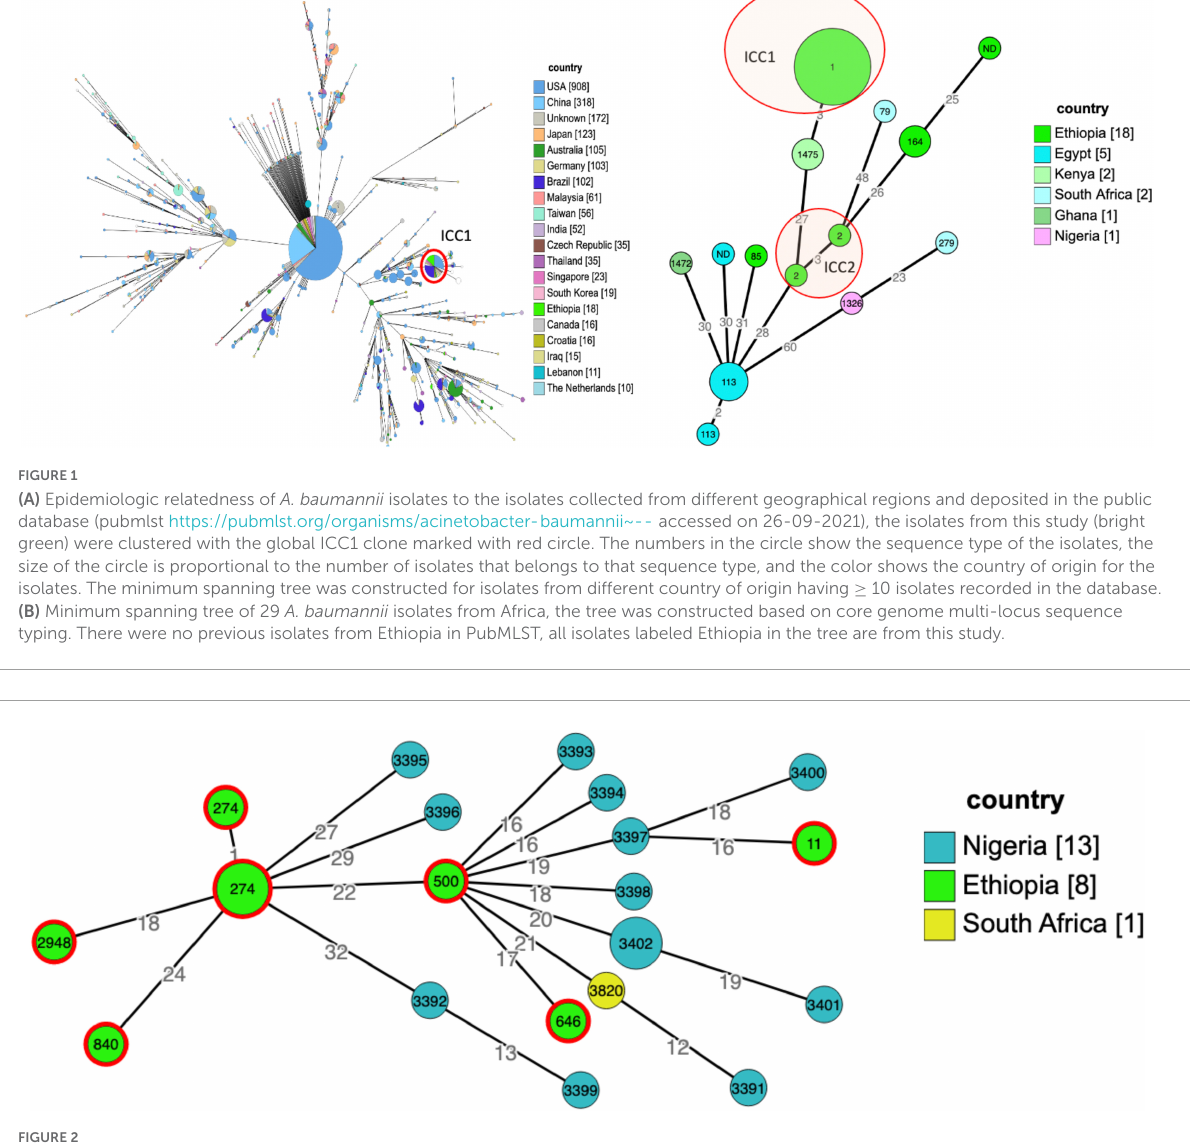
FIGURE2 Grape tree generated using cgMLST from genomic collection of Pseudomonas aeruginosa isolates from Africa ( n = 22), Ethiopia, Nigeria, and South Africa, pubmlst database for microorganisms (https://pubmlst.org/bigsdb?db=pubmlst_paeruginosa_isolates&page=query&genomes=1) accessed on 29-11-2021. The numbers in circles/nodes indicate sequence types of the isolates, size of the nodes is proportional to the number of isolates in a particular sequence type and the numbers on the branches are the number of allelic differences between the two neighboring nodes. From 10 isolates sequenced in this study, eight were included in the tree, two of the sequences failed quality required to upload to the pubmlst